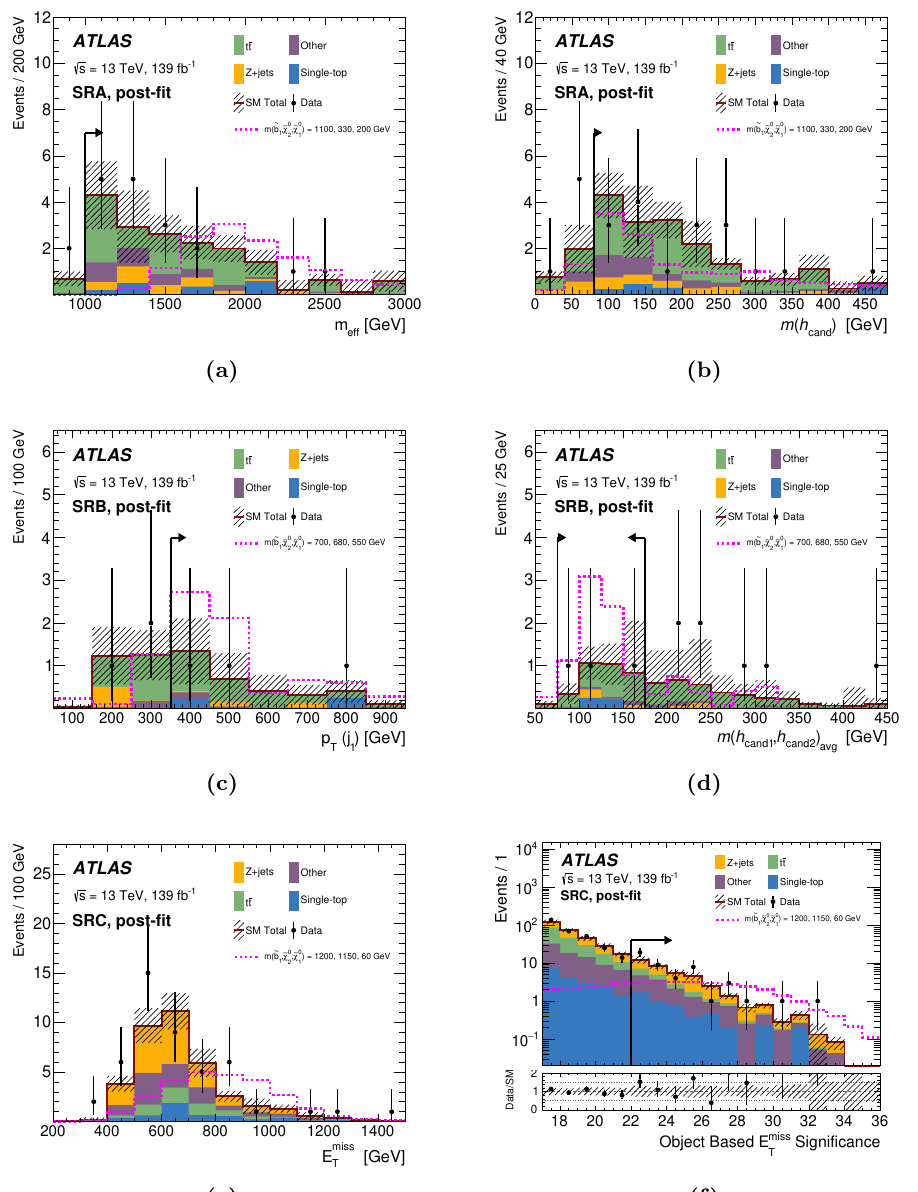
Figure 7. Post-(cid:12)t distributions of (a) the m e(cid:11) and (b) the m ( h cand ) in the inclusive SRA region; (c) the leading jet p T and (d) the m ( h cand1 ; h cand2 ) avg for the Higgs candidates in the SRB region; (e) E miss and (f) S for SRC regions. All SR selections are applied except for the selection on the T variable shown, where the selection on the variable under consideration is denoted by an arrow, except in the case of (e), where the full SRC selection is applied. All uncertainties as de(cid:12)ned in section 7 are included in the uncertainty band. The minor backgrounds (diboson, W +jets and t (cid:22) t + W=Z=h ) are grouped and labelled as \Other". For illustration, contributions expected for scenarios with di(cid:11)erent bottom-squark, ~ (cid:31) 0 and ~ (cid:31) 0 masses depending on the SR considered are superimposed. 2 1 Over(cid:13)ow events which do not fall into the axis range are placed into the right-most bin.